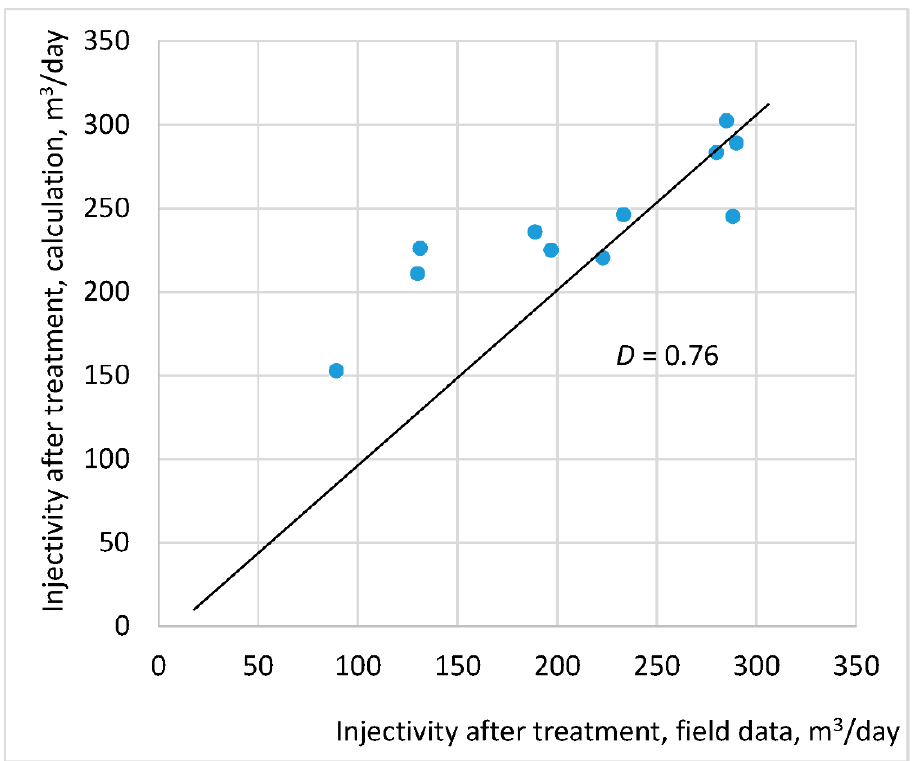
Figure 3. Comparison of post-treatment injectivity, calculated in the developed mathematical model, with its actual value.